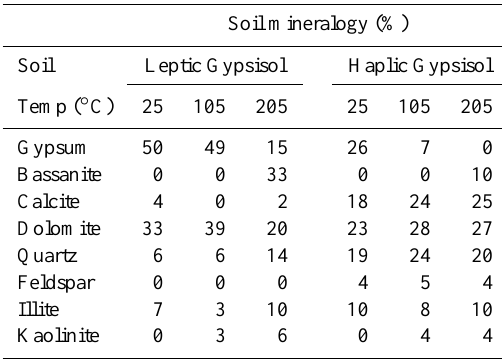
Table 3. Mineralogy of the soil (2mm mesh). Soil mineralogy